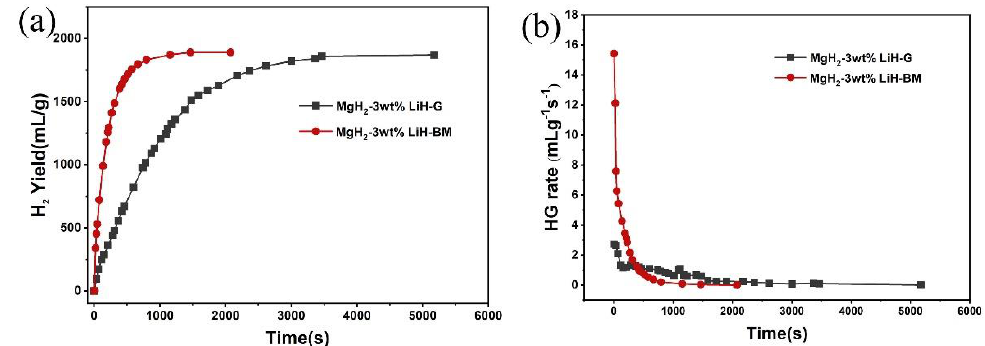
Figure 6. ( a ) Hydrogen generation curves and ( b ) hydrogen generation rate of MgH 2 -3 wt % LiH-BM and MgH 2 -3 wt % LiH-G.